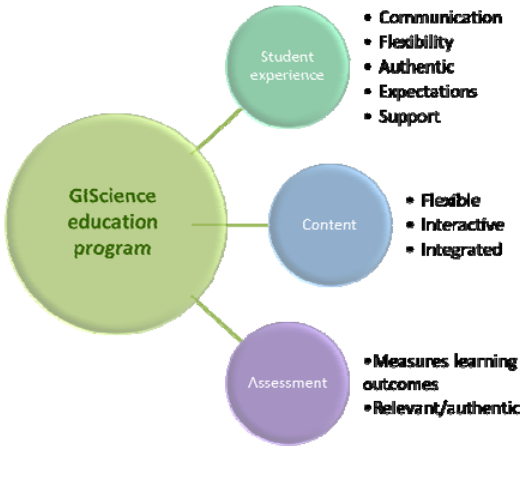
Figure 3: Education framework for a GIScience program Another distinguishing feature is the mode of delivery of content. In the early eras of GIScience education, programs were offered as either face-to-face or distance based, or both. In fact, the content was often packaged differently to cater for the different modes of learning. For example, the GITTA project developed online pools of lessons and learning materials which could then be organised into different courses for e-learning (Weibel et al. 2012). In the early development of the GIScience distance programs at Curtin University, the content was assembled into online modules for distance students to work through them independently.